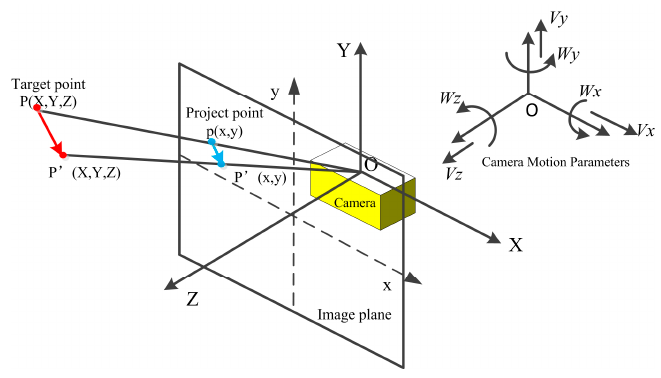
Figure 2. 3D motion and planar imaging model.